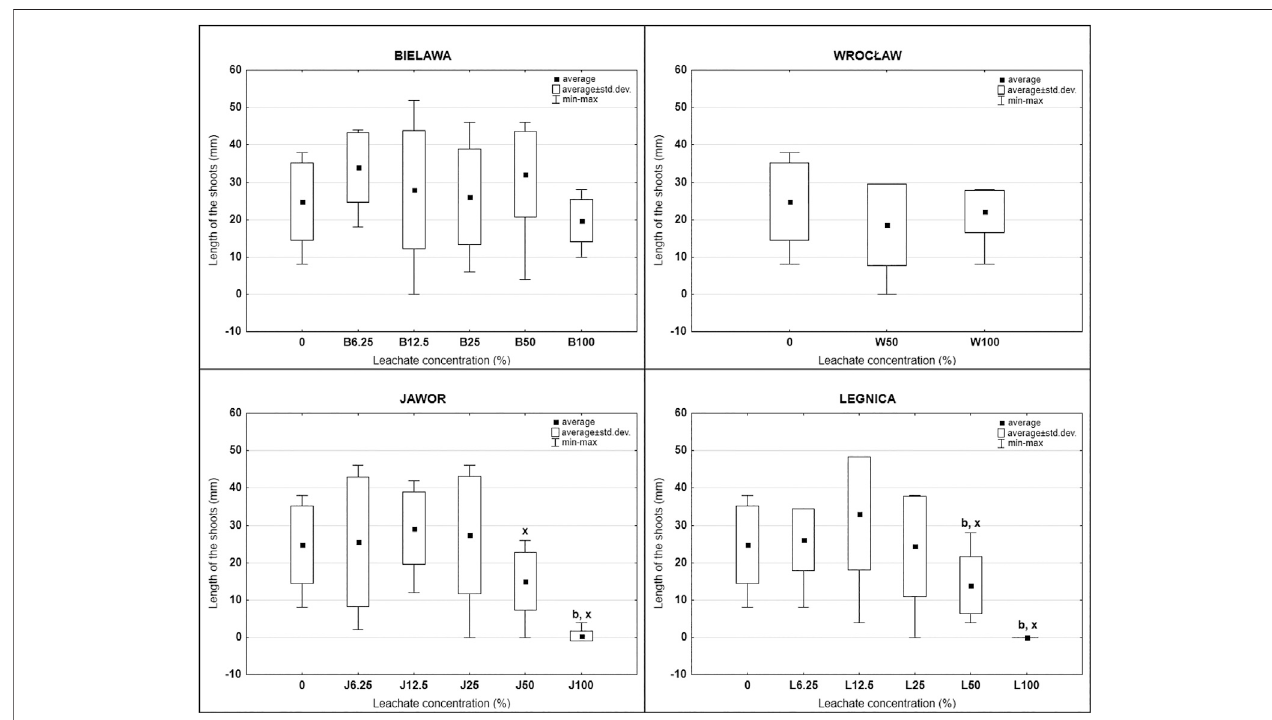
FIGURE 5 | Characteristic values (mean, standard deviation, minimum, maximum) for shoot length measurements results-series 09.2019.